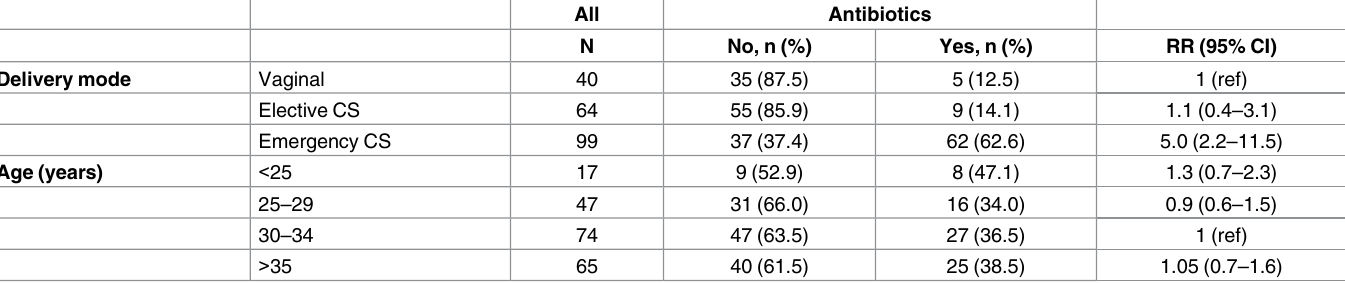
Table 1. Risk ratios (RR) and 95% confidence intervals (CI) for antibiotic treatment in relation to delivery mode and maternal age at delivery (N = 203).